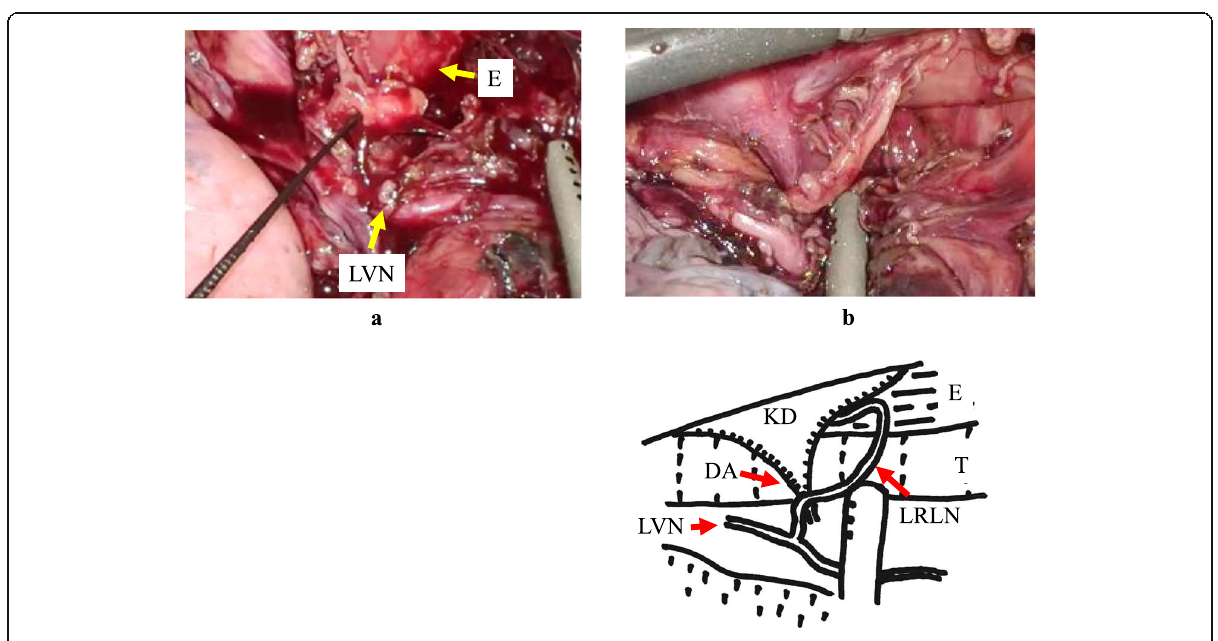
Fig. 3 Intraoperative findings. a Identification of the left recurrent laryngeal nerve was performed by the needle-type sensor of the nerve integrity monitor. b Dissection around the left recurrent laryngeal nerve that encircled the ductus arteriosus has been completed. c Schematic illustration. E: esophagus, T: trachea, LVN: left vagus nerve, KD: Kommerell ’ s diverticulum, DA: ductus arteriosus, LRLN: left recurrent laryngeal nerve